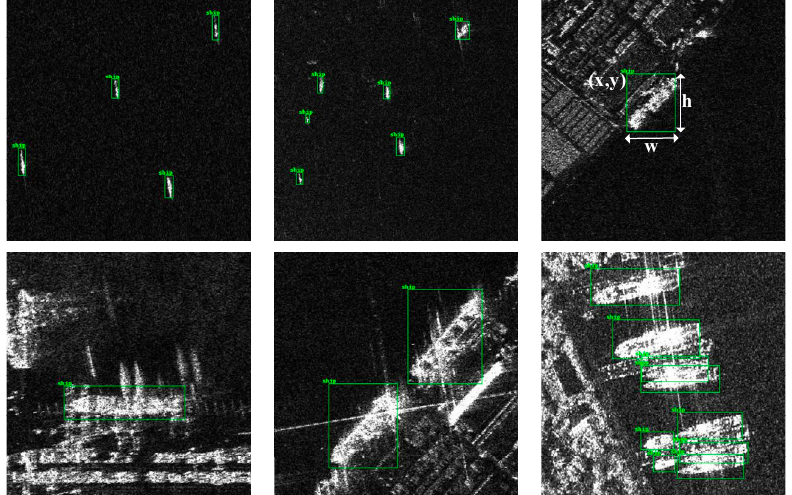
Figure 7. Sample images and labels from SSDD.